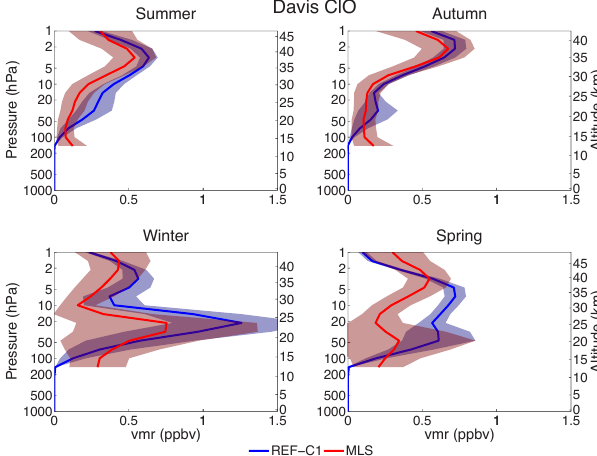
Figure 6. Comparison of seasonal average vertical profiles of ClO averaged between 67.5–70 ◦ S and 78.75–82.5 ◦ E. Seasonal average data are from 2005 to 2010 for REF-C1 and MLS. Shaded regions show 1 standard deviation. Altitude values are